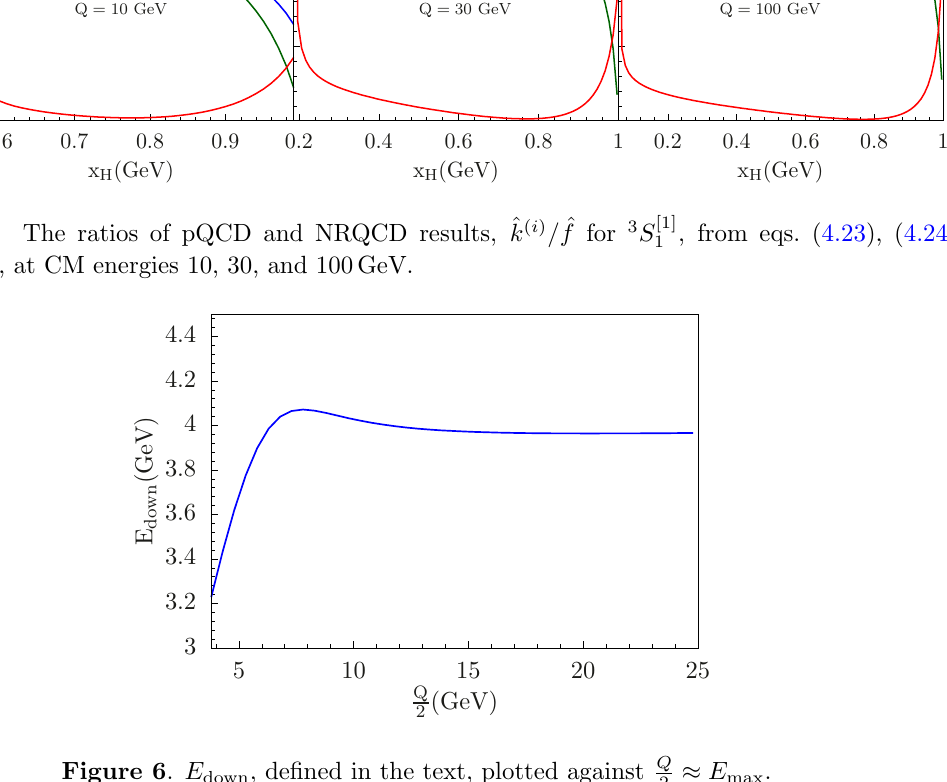
Figure 6 . E down , de(cid:12)ned in the text, plotted against Q